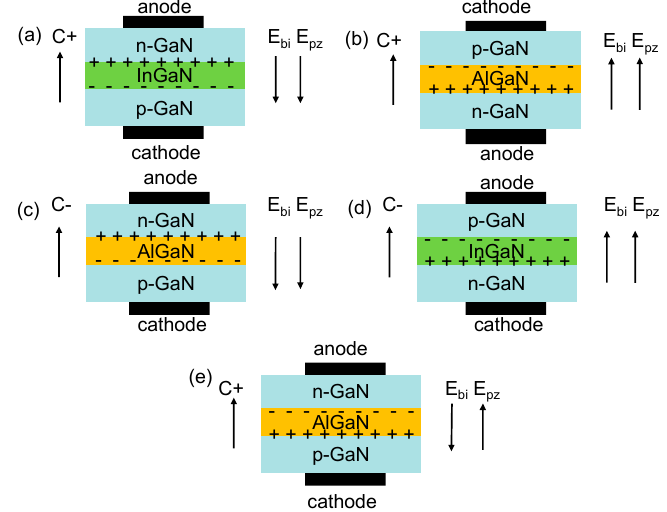
Figure 3. ( a ) [0001] oriented n-GaN/InGaN/p-GaN polarization tunnel junction; ( b ) [0001] oriented p-GaN/AlGaN/n-GaN polarization tunnel junction; ( c ) [000-1] oriented n-GaN/AlGaN/p-GaN polarization tunnel junction; ( d ) [000-1] oriented p-GaN/InGaN/n-GaN polarization tunnel junction and ( e ) [0001] oriented dielectric-constant-controlled (DCC) tunnel junction. E bi , E pz represent the built-in electric field and the polarization induced electric field, respectively.